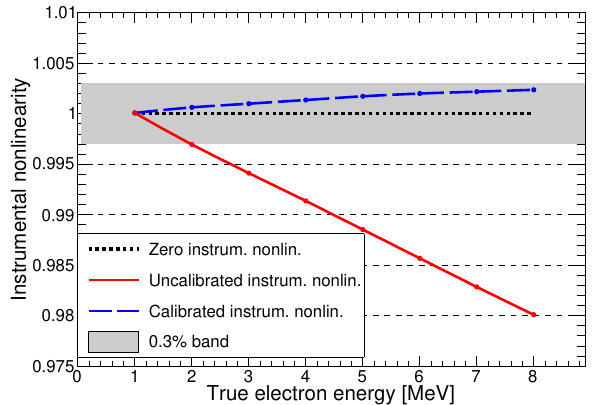
Figure 3 . Event-level instrumental non-linearity, defined as the ratio of the total measured LPMT charge to the true charge for events uniformly distributed in the detector. The dotted black line represents the perfect linear case. The solid red line represents event-level non-linearity without the channel-level correction, with position non-uniformity obtained at 1 MeV applied, in an extreme hypothetical scenario of 50% non-linearity over 100 PEs for the LPMTs. The dashed blue line represents that after the channel-level correction. The gray band shows the residual uncertainty of 0.3%, after the channel-level